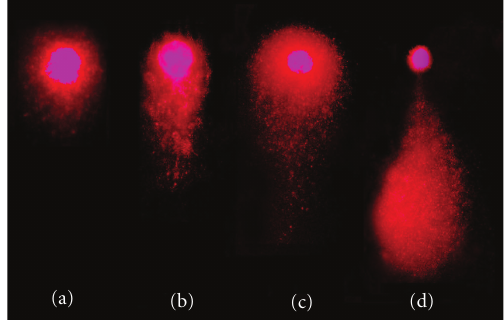
Figure 2: Epithelial cells of the cervix processed using DBD- FISH on neutral comet to determine dsb and ssb simultaneously using whole-genome-labeled ( red ) and DAPI counterstained ( blue ) cells. Cell of patients with HG-SIL (c) and exhibit an increase in the migration length (dsb) and in the fluorescence intensity (ssb) compared with cells from control women ((a) and (b)). Apoptotic cell was concluded to form comets with large fan-like tails and small heads (i.e., so-called hedgehogs)